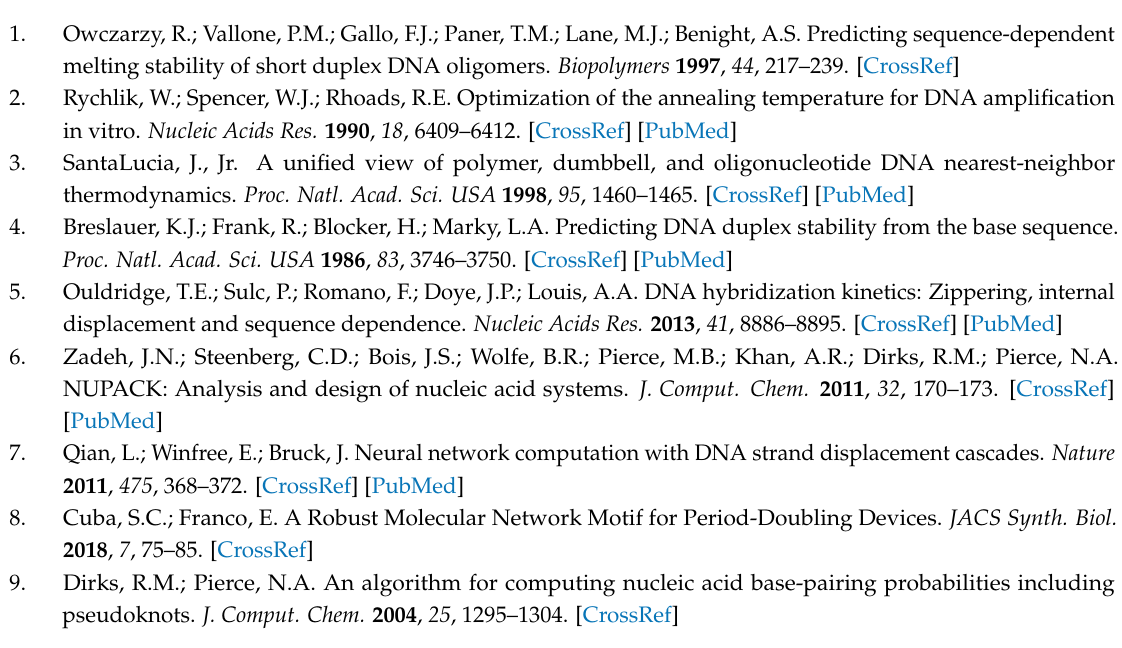
Figure S2: Calculation of the multiple reaction equilibrium of two analogs, Figure S3: Calculation of the concentration of the RS, Figure S4: Calculation of the Pearson’s correlation coefficient, Figure S5: The random sets of two analogs and the calculation of the RS, Figure S6: The random sets of five analogs (eight bases, three mutations), and the calculation of the RS, Figure S7: The random sets of five analogs with mutation number